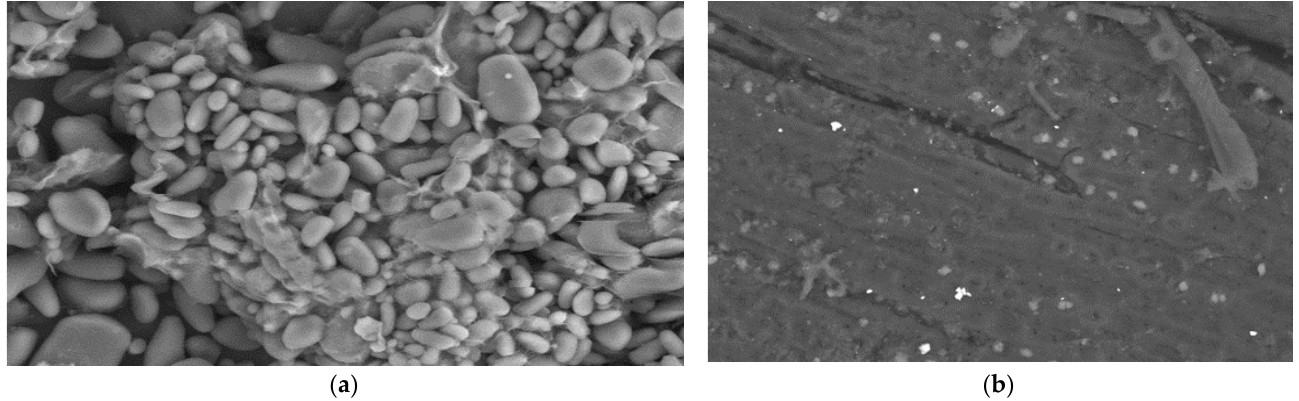
Figure 1. SEM micrographs of OPB ( a ) before and ( b ) after Cr (VI) adsorption with magnification of ×500.